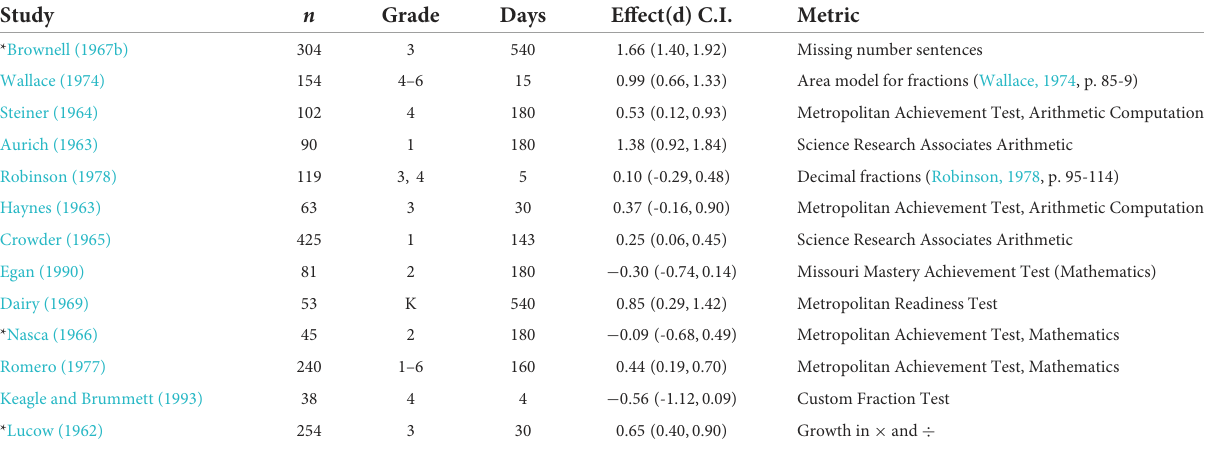
TABLE 1 Experiments included in the post-test meta-analysis ranked in order of fidelity (Peer reviewed findings are marked *).